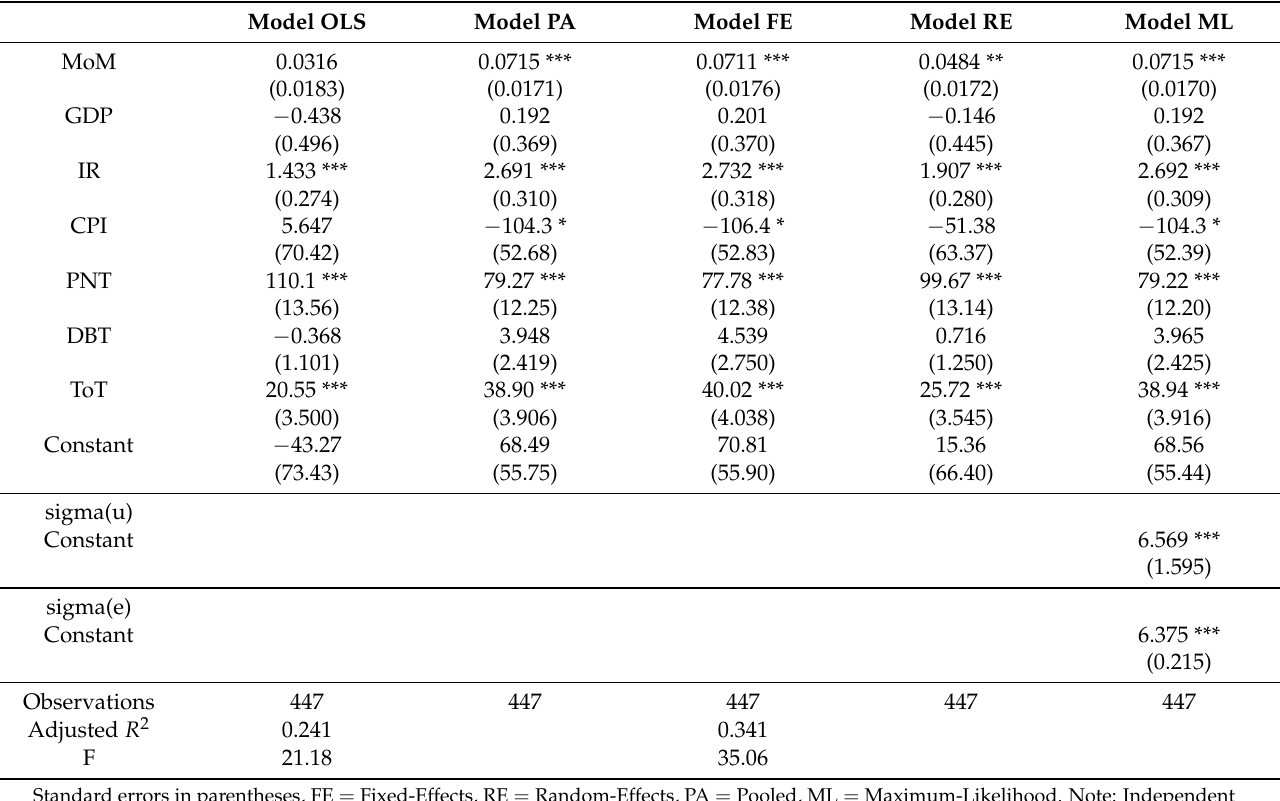
Table 4. Panel Regression Table AM